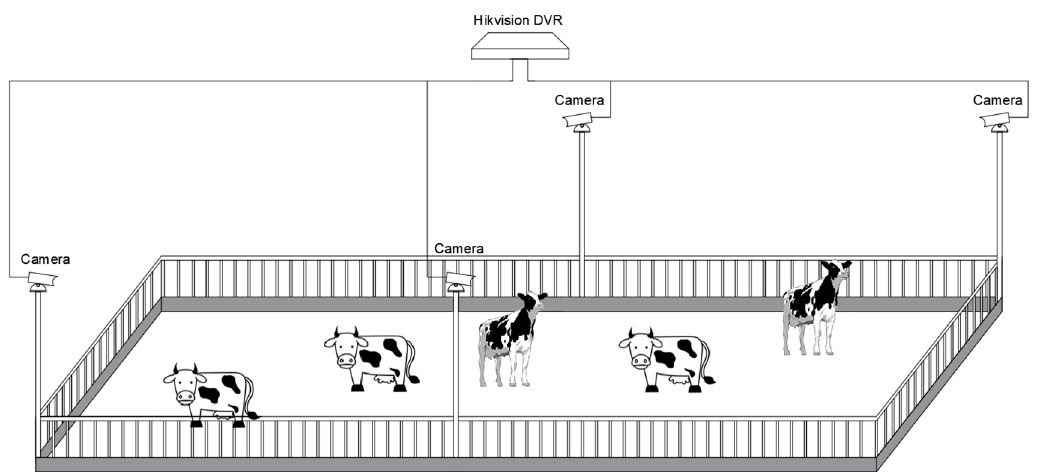
Figure 1. Schematic diagram of installation of estrus data acquisition equipment.